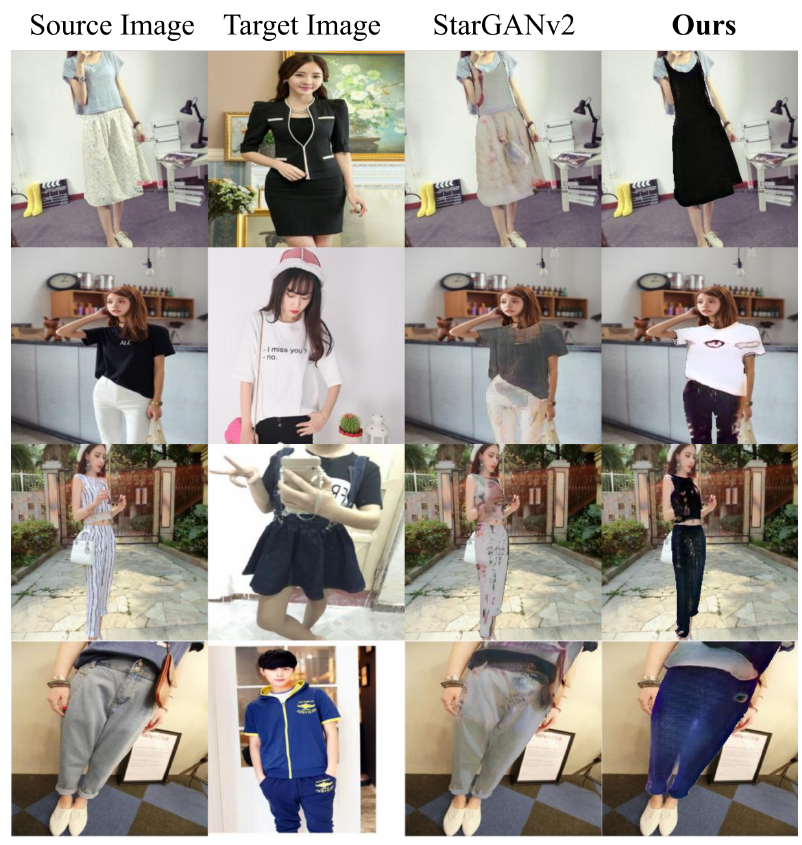
Figure 5. Comparison between baseline StarGANv2 and our method.